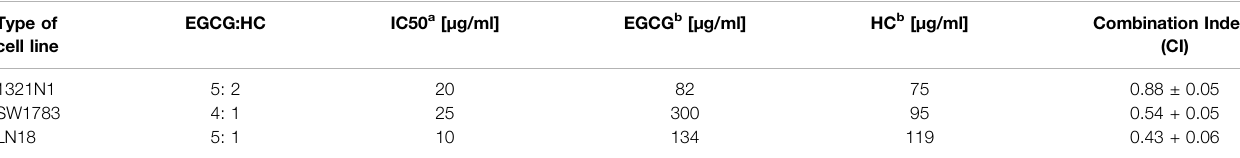
TABLE 2 | The ratio of combined EGCG and HC at 50% inhibitory concentration (IC50) of 1321N1, SW1783, LN18 cells and its combination index (CI). Type of cell line